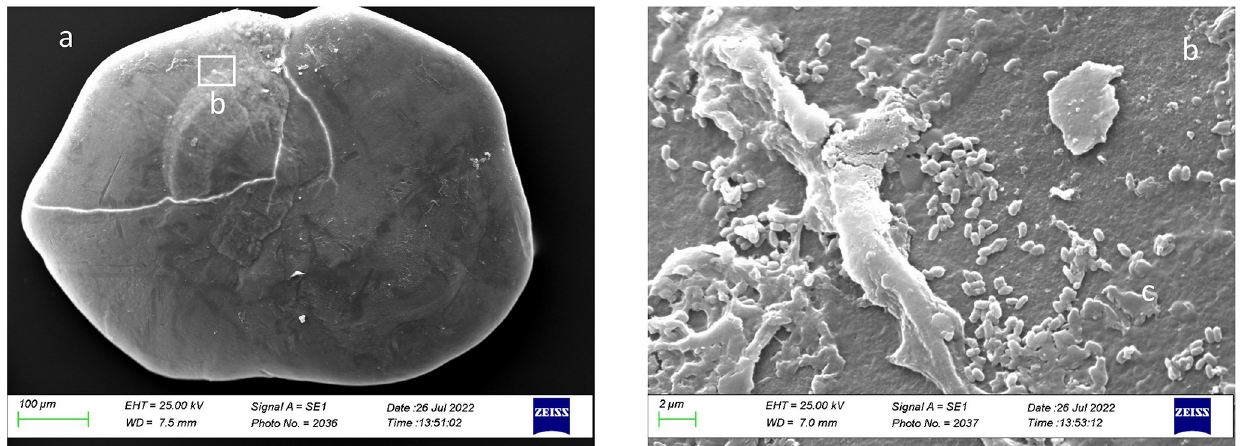
Fig 16. SEM images of a right sagitta external surface belonging to size Class IV (a) with details of the crystalline habits and external textural organization (b).